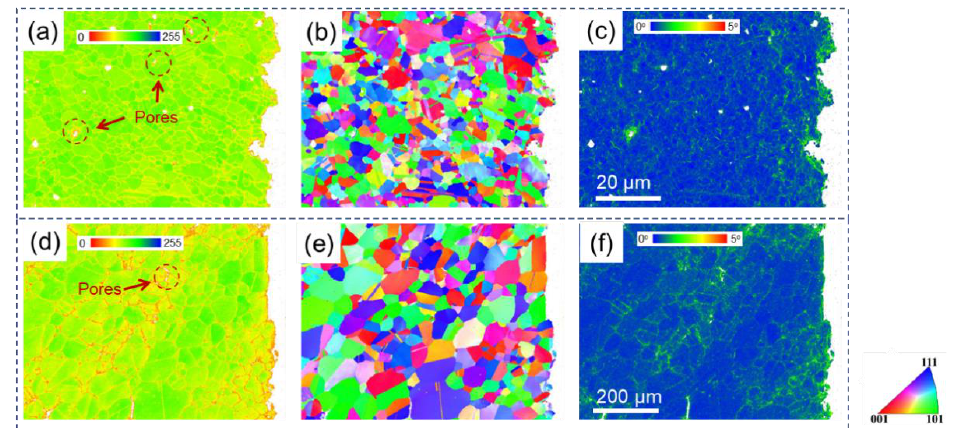
Figure 7. BC ( a , d ), IPF ( b , e ), and KAM ( c , f ) maps of SL ( a – c ) and SH ( d – f ) near fracture at 830 °C. The frequency distribution histograms of the KAM values for both specimens are shown in Figure 8. For SL after tension at 550 ◦ C (Figure 8a), the KAM values are obviously higher than those for an undeformed specimen. On the other hand, the KAM values of the specimen after tension at 750 ◦ C and 830 ◦ C are comparable to those of an undeformed specimen. The KAM distribution difference for SL after deformation at 550 ◦ C, 750 ◦ C, and 830 ◦ C can be seen intuitively from Figures 5, 6 and 7c, in which a higher KAM level is widely distributed at 550 ◦ C but remains low at both 750 ◦ C and 830 ◦ C, compared to the undeformed specimen (Figure 3c). For SH after deformation at all three temperatures, three KAM distributions all drifted to the right from those of the undeformed specimen, which can be seen in Figure 8b. In addition, with an increase in deformation temperature, the KAM distribution histograms moved towards the left side, indicating lower local misorientations after deformation at a higher temperature.